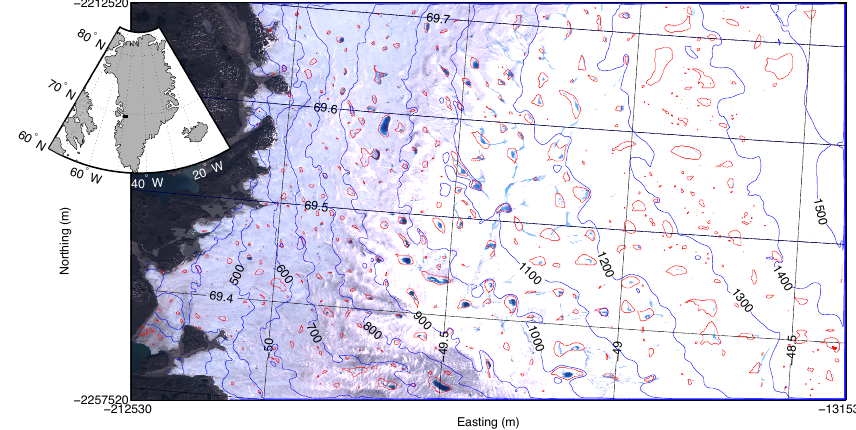
Figure 1. Location map of the study area. Detailed map shows Landsat true-colour image for 7 July 2001. Coordinates are for a Polar Stereographic projection, EPSG Code 3413. Red lines show maximum possible lake extents calculated from the DEM using the method of Arnold (2010). Black rectangle in inset map shows study area location within Greenland.